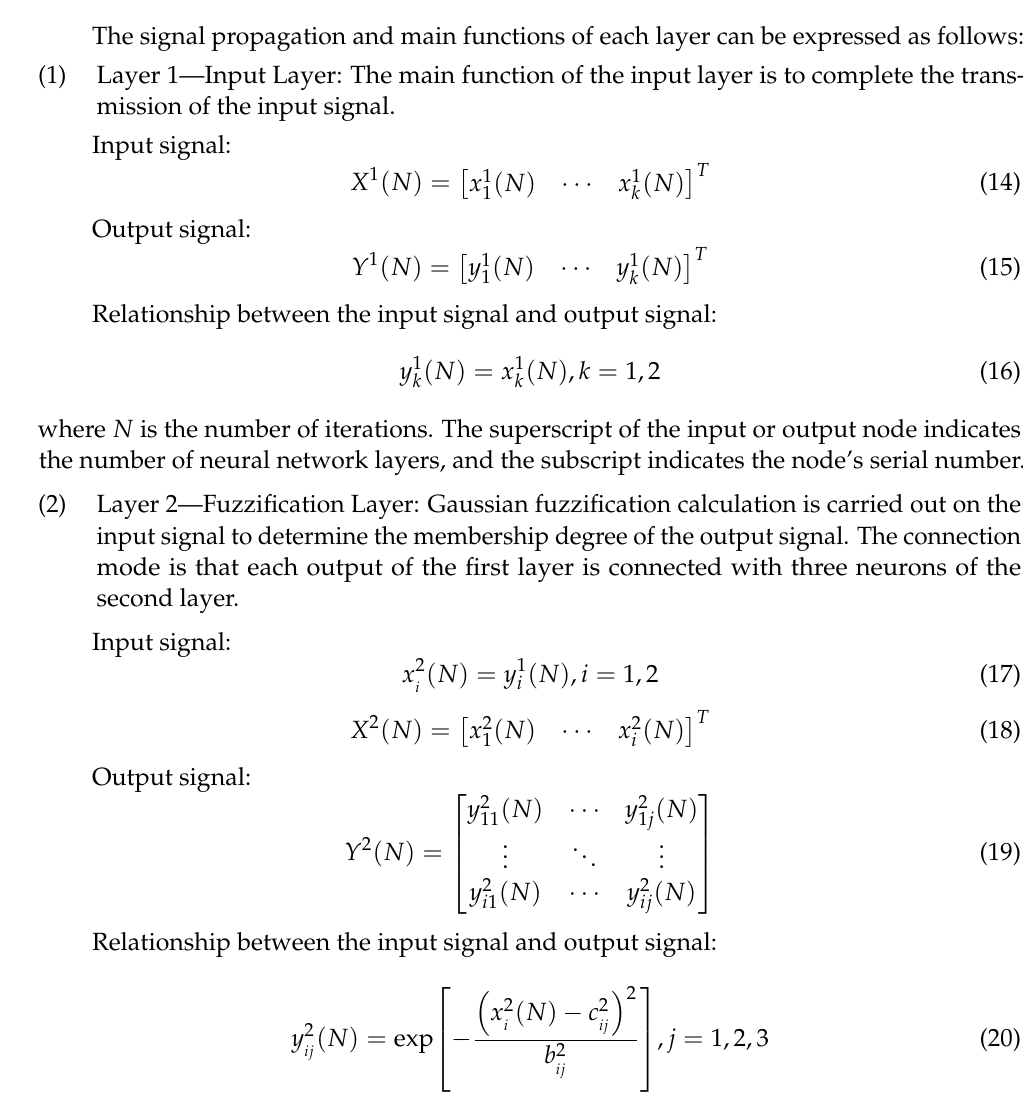
Figure 3. Structure of the GRU.